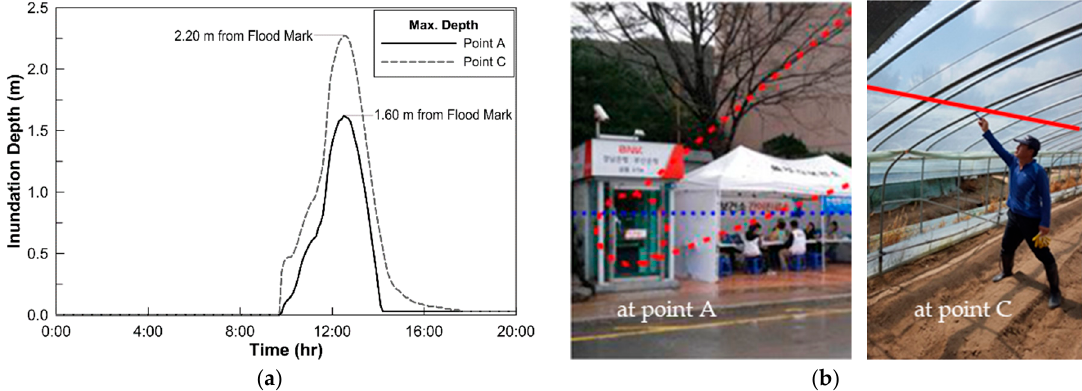
Figure 8. Verification points.